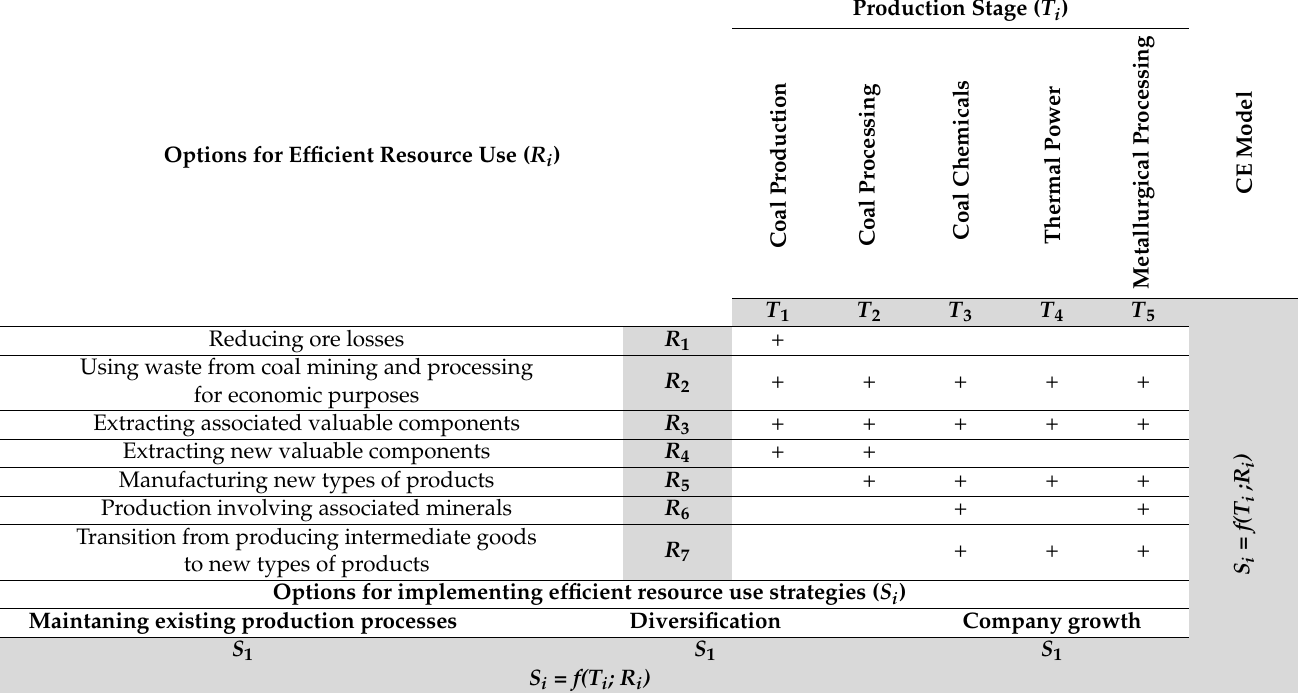
Table 3. Conceptual framework for developing circular business models at the industry level for the coal sector. Source: compiled by the